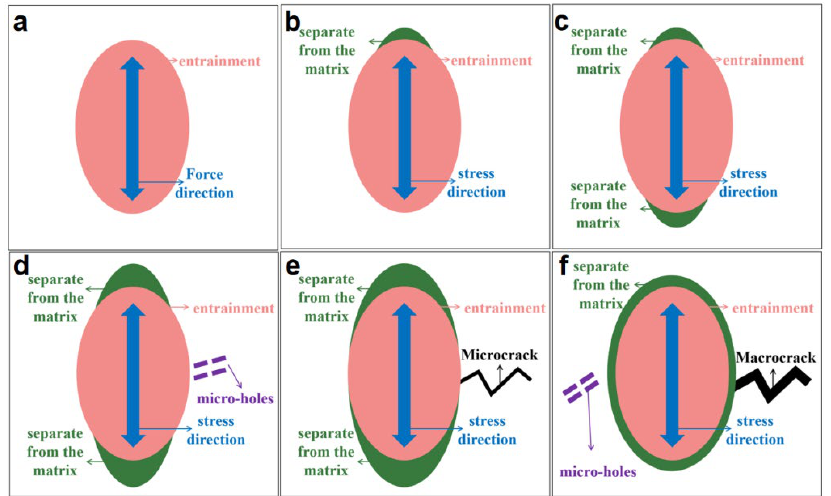
Figure 14. Fatigue crack initiation caused by inclusions and second-phase particles: ( a ) stress alternation effect on entrainment; ( b ) one side separates from the matrix; ( c ) both sides separate from the matrix; ( d ) micro-hole appears; ( e ) microcracks appear; ( f ) micro-holes appear again .